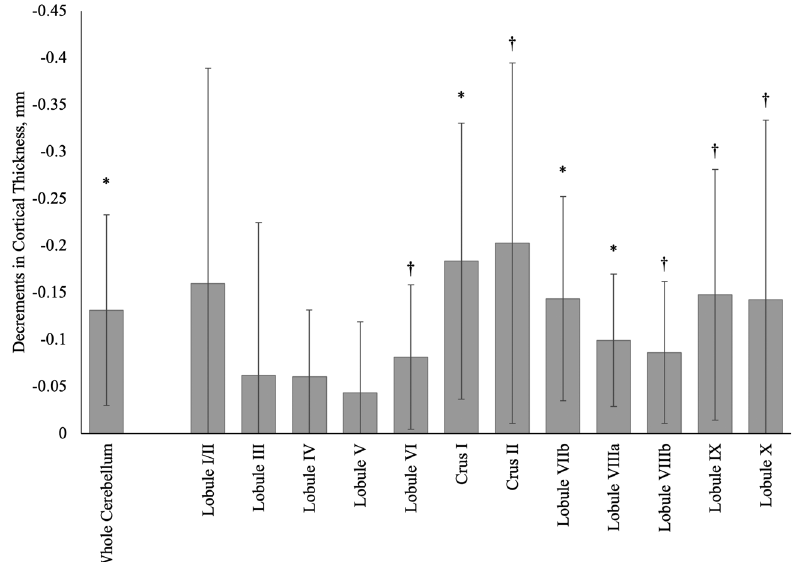
Fig. 2 Reductions in mean bilateral cortical thickness (mm) in the whole cerebellum and across 12 cerebellar regions of interest in World Trade Center responders with cognitive impairment ( n = 48) when compared to WTC responders who were cognitively unimpaired ( n = 51). Con fi dence intervals are shown using error bars. Reductions with con fi dence intervals not crossing the base line were nominally signi fi cant, while those marked with * survived adjustment for the false discovery